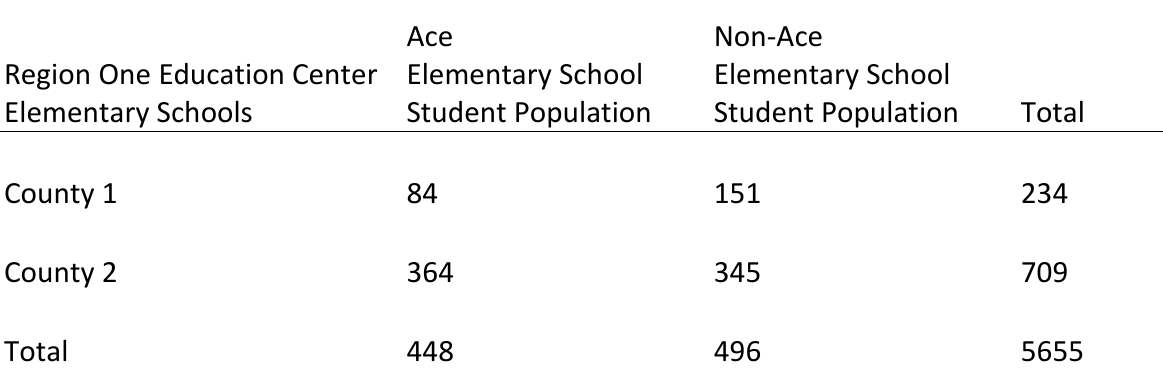
Table 2 : Descriptive Statistics on the campus student population implementation and non- implementation of the 21 st Century Afterschool Centers on Education for 4 th grade students